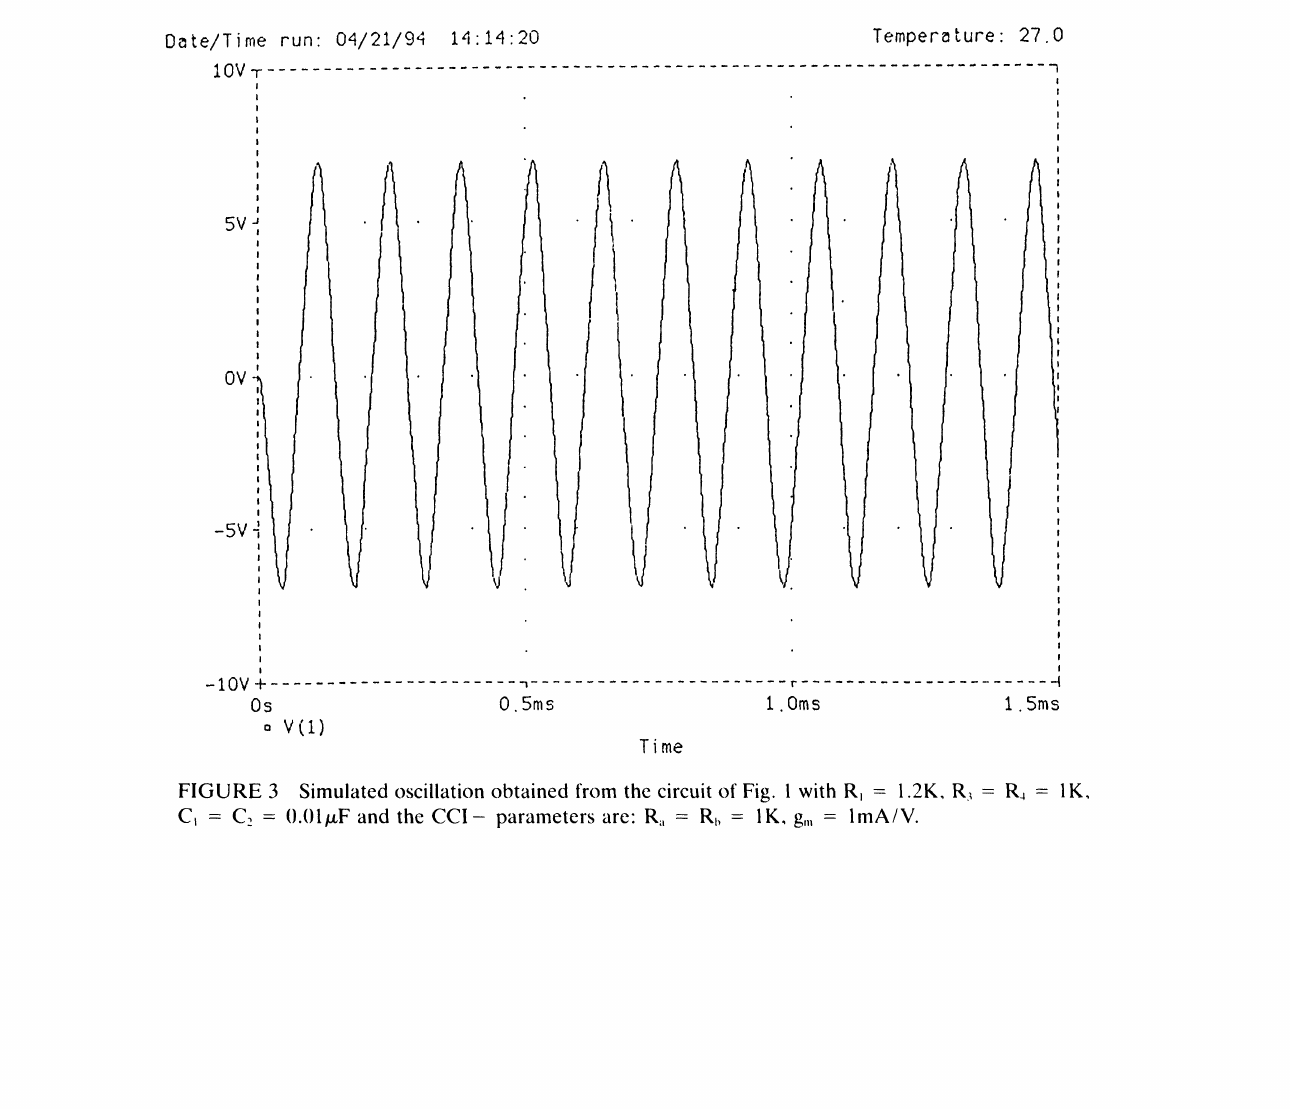
FIGURE 3 Simulated oscillation obtained from the circuit of Fig. with R 1.2K,